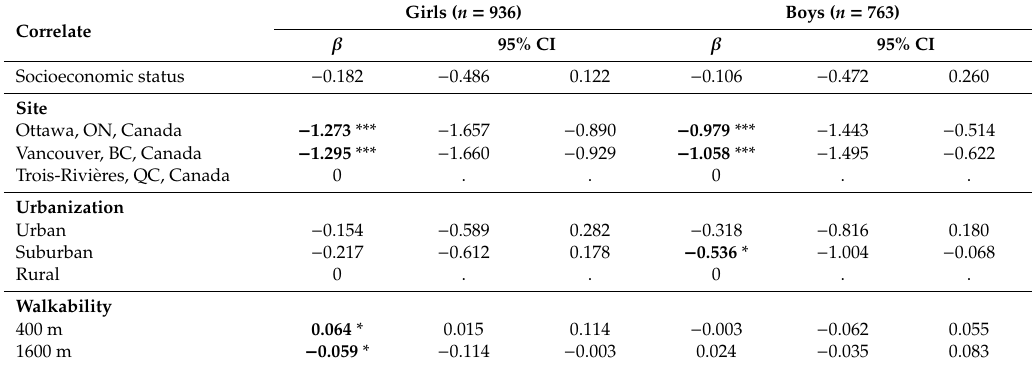
Table 4. Geographical and area-level correlates of children’s independent